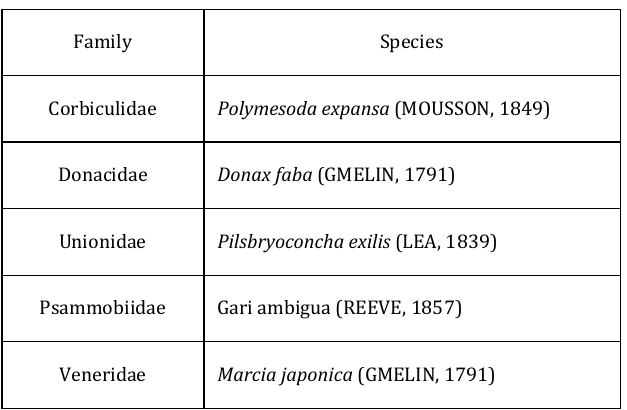
Table 3: Family of infaunal bivalves and the representative species from